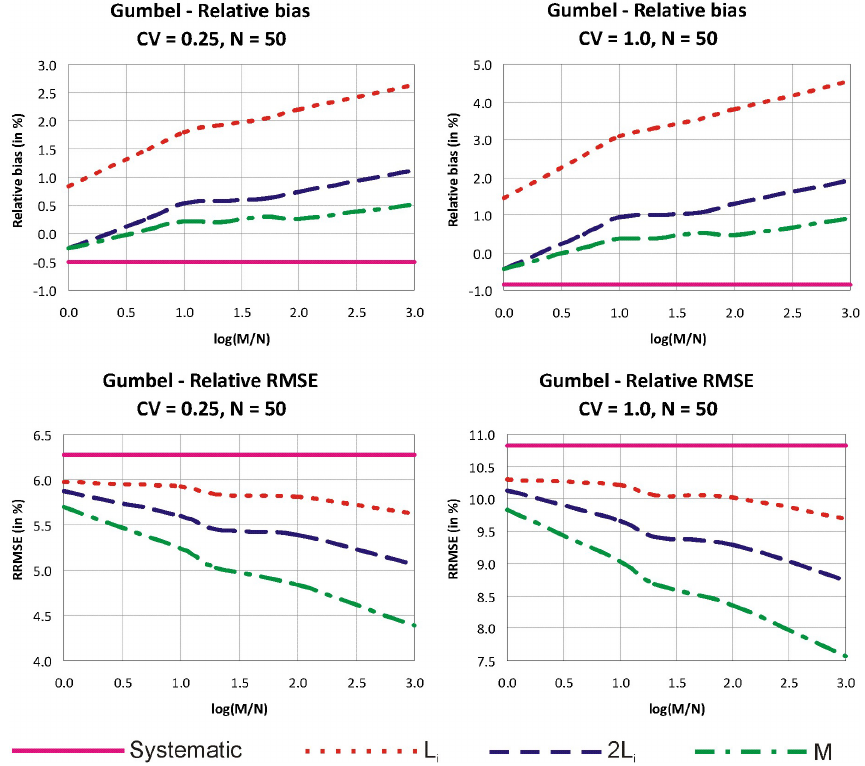
Figure 3. RB and RRMSE of ˆ X T = 100 as a function of gauge record length N and historic period M for ˆ M i = 0 , L i , 2 L i , M . Parent distribution Gumbel with CV equal 0.25 and 1.0 and N = 50. Fitted distribution